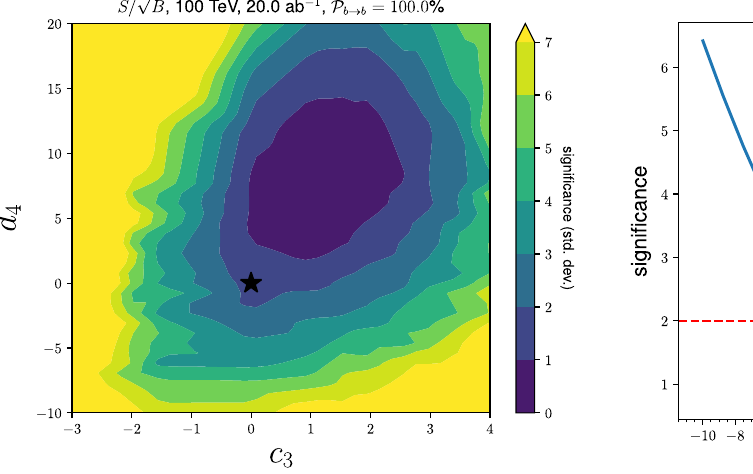
Fig. 7 The significance for our analysis of triple Higgs boson produc- tion in the ( b ¯ b )( b ¯ b )( b ¯ b ) final state with modified quartic self-coupling ( λ 4 = λ SM ( 1 + d 4 ) ) and no modification to the triple self-coupling ( c 3 = 0) at the FCC-hh at 100 TeV. We have assumed an integrated luminosity of 20 ab − 1 and perfect b -tagging. The red dashed lines indi- cate the 2 σ points for the constraints on d